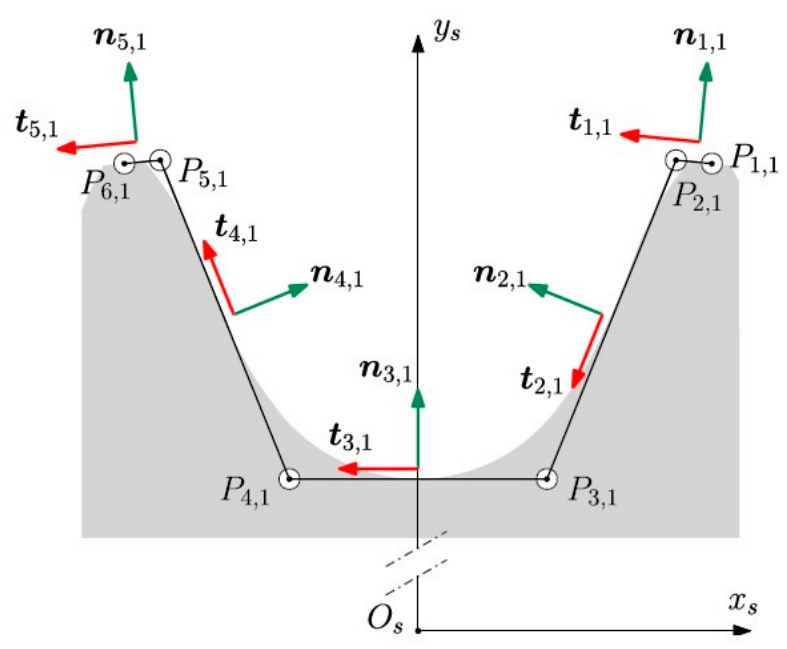
Figure 14. Approximation of the sprocket tooth profile using five straight-line segments.